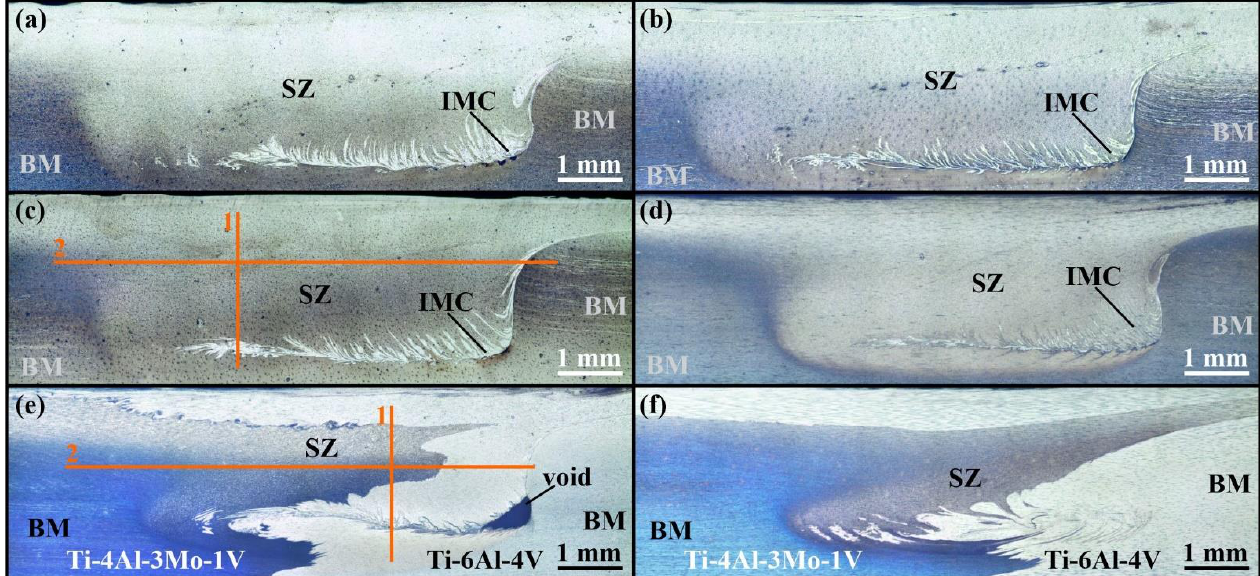
Figure 3. Cross-sectional metallographic image of Ti-4Al-3Mo-1V alloy joint specimen № 1 ( a ), № 2 ( b ), № 3 ( c ), № 4 ( d ), and Ti-4Al-3Mo-1V—Ti-6Al-4V alloy joint specimen № 5 ( e ), № 6 ( f ): 1,2—track of microhardness measurement.